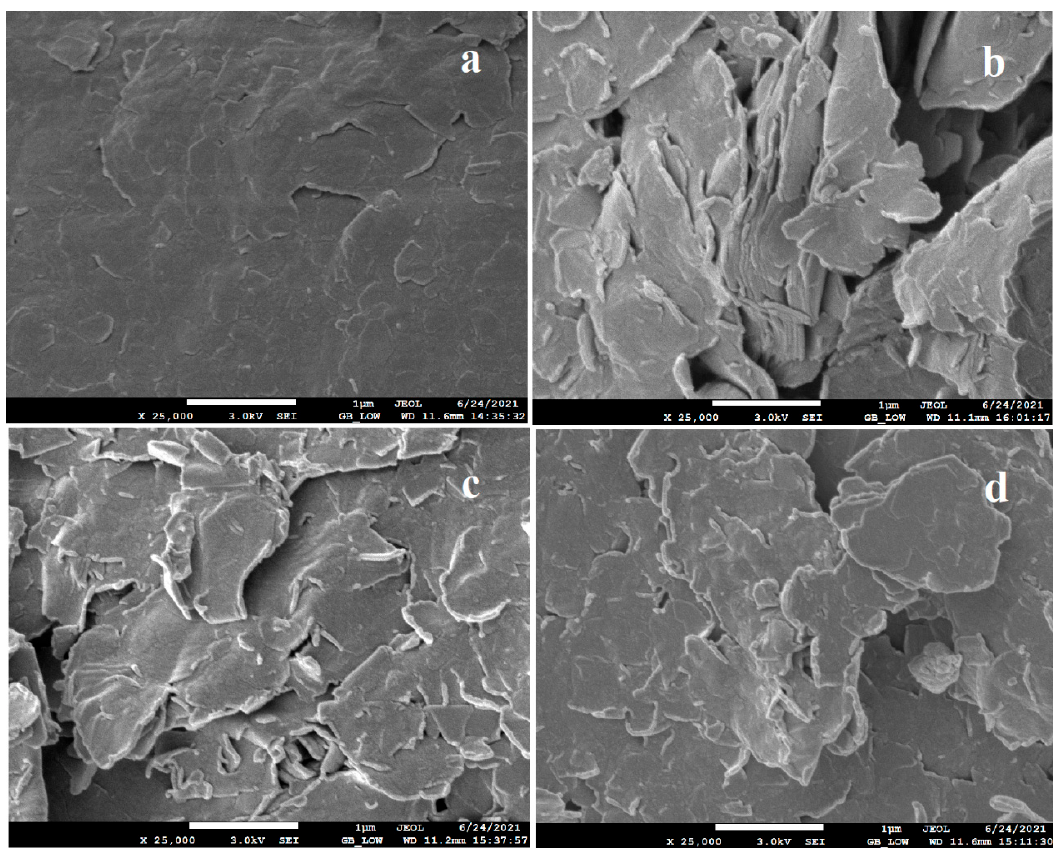
Figure 5. SEM images of: ( a ) BEI × 25,000; ( b ) BEI_BA × 25,000; ( c ) BEI_CP × 25,000; ( d ) BEI_TD × 25,000.